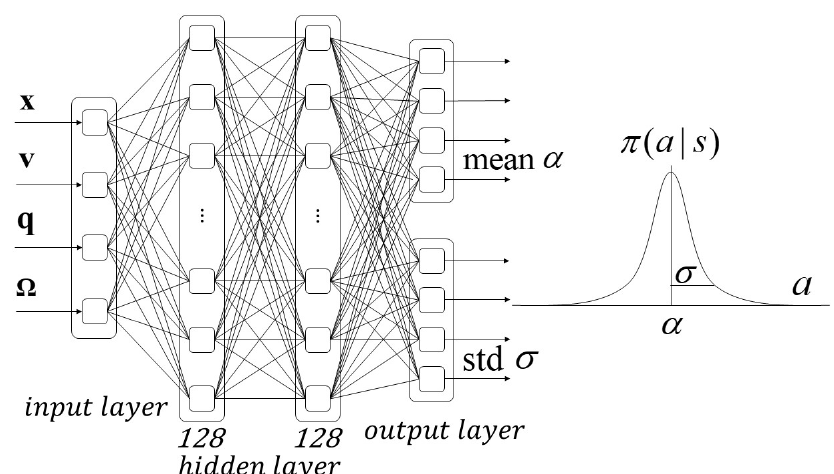
Figure 3. Policy neural network approximation structure, consisting of two hidden layers with 32 rectified linear unit nodes in each layer. The neural network outputs the mean α and standard deviation σ of the Gaussian distribution to generate the control